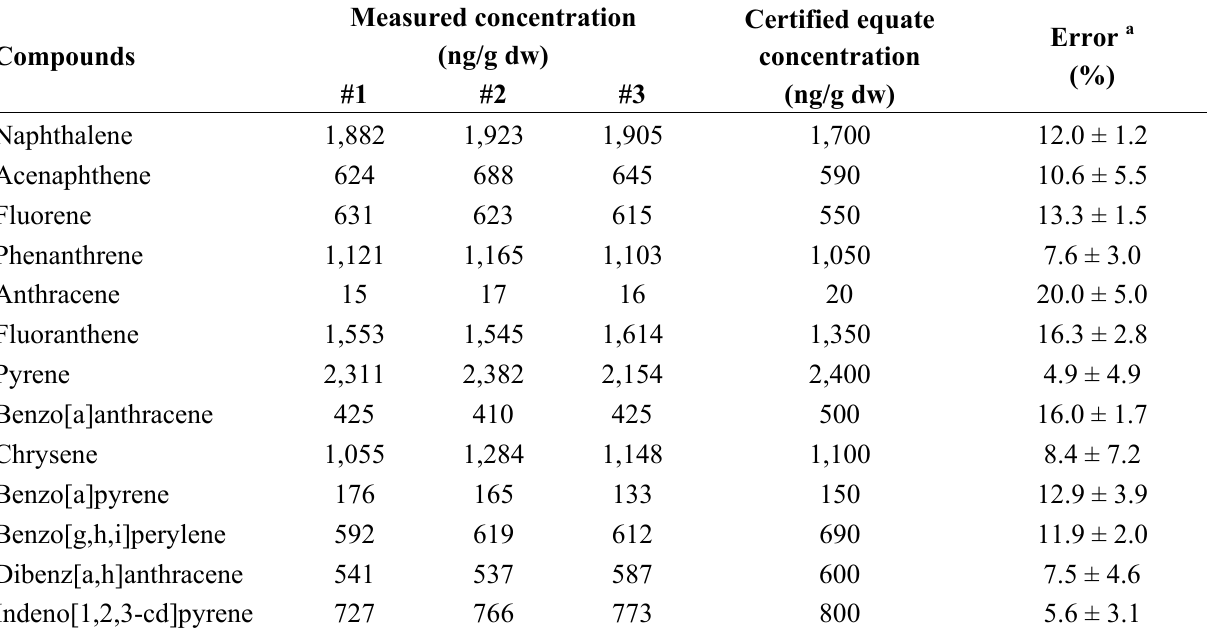
Table 3. Errors of individual PAHs in reference materials SES-1 (polycyclic aromatic hydrocarbons in spiked estuarine sediment) made in this